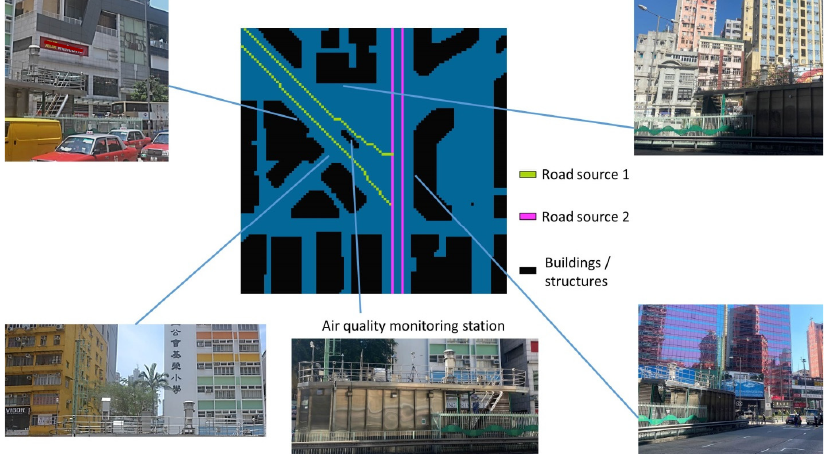
Figure 1. The site environment. The CFD model domain (center) and snapshots around the site are shown.